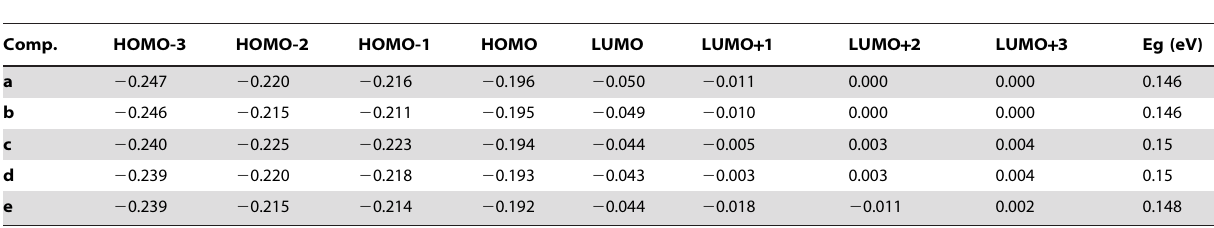
Table 5. Frontier orbitals and energy gaps